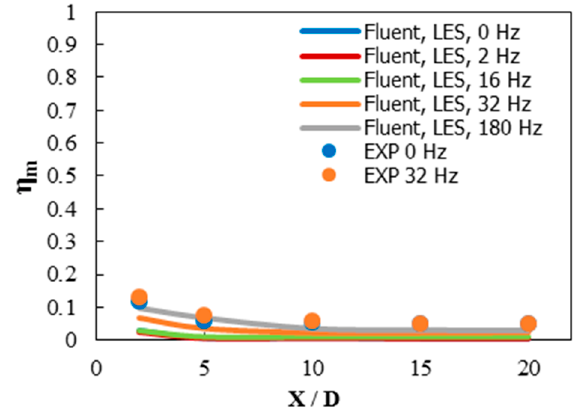
Figure 38. The spanwise-averaged effectiveness obtained using the LES Smagorinsky–Lilly model for M = 1.0 for the 0, 2, 16, 32, and 180 Hz oscillations.